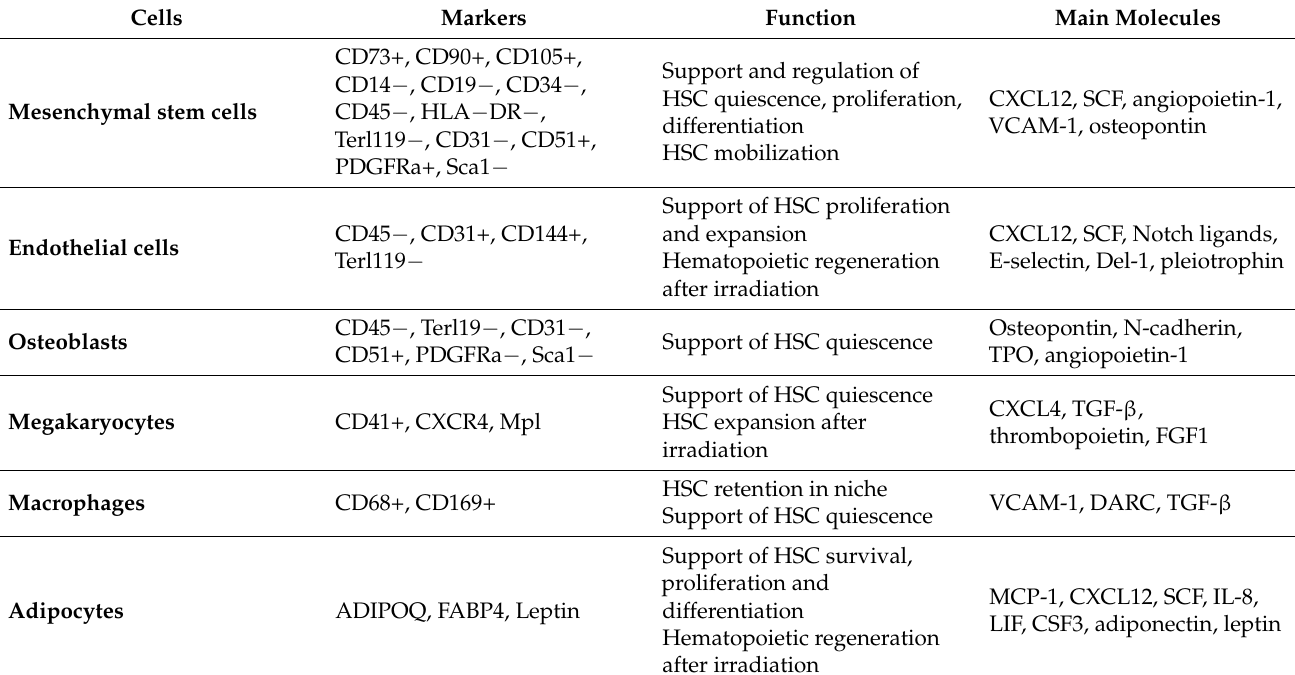
Table 1. Key cell types participating in regulation of HSCs activity in BM